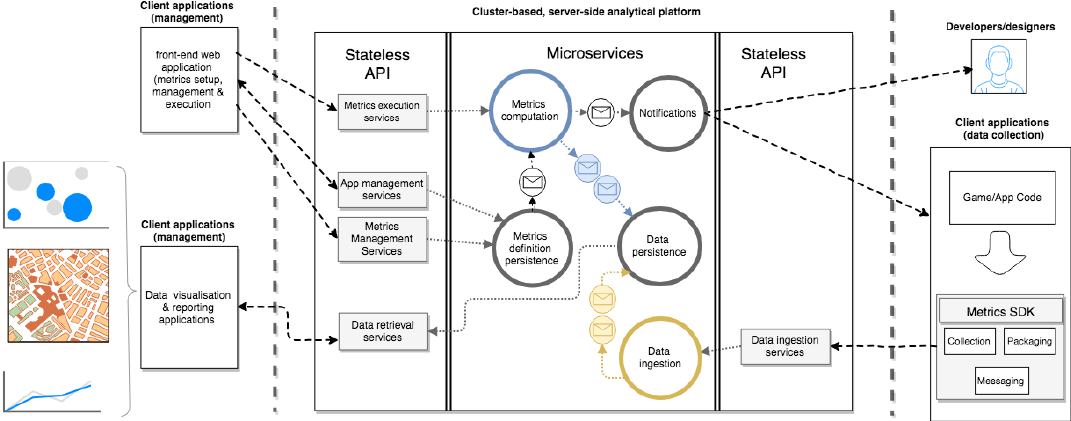
Figure 1. Layered architecture of the analytics platform for computing spatio-temporal metrics. The server-side platform is placed in the central part, whereby the client side applications are on either side and communicate with the server-side through stateless Application Programming Interfaces (APIs). Yellow denotes stream-processing methods, blue denotes batch-processing